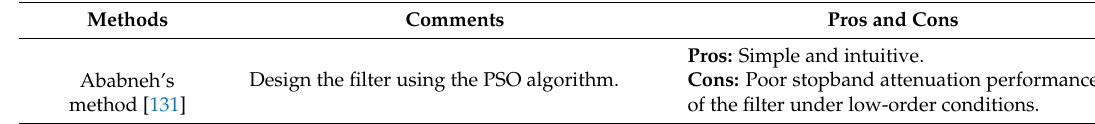
Table 5. Summary of optimization based